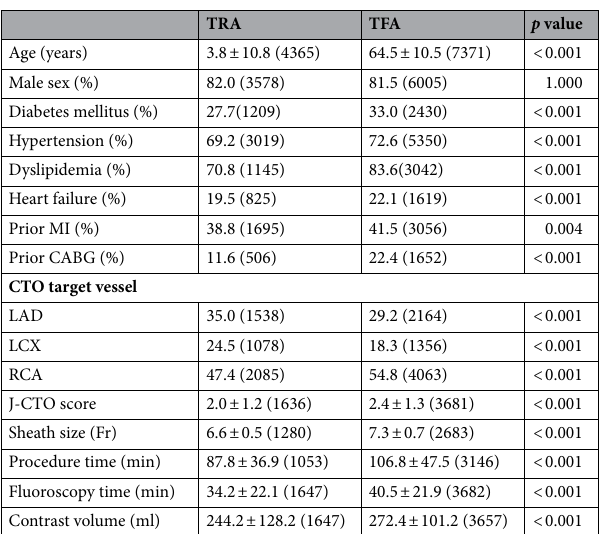
Table 2. Patients’ demographics and CTO target vessel. Data are expressed as mean ± standard deviation or as number (percentage). CTO chronic total occlusion, TRA transradial access, TFA transfemoral access,